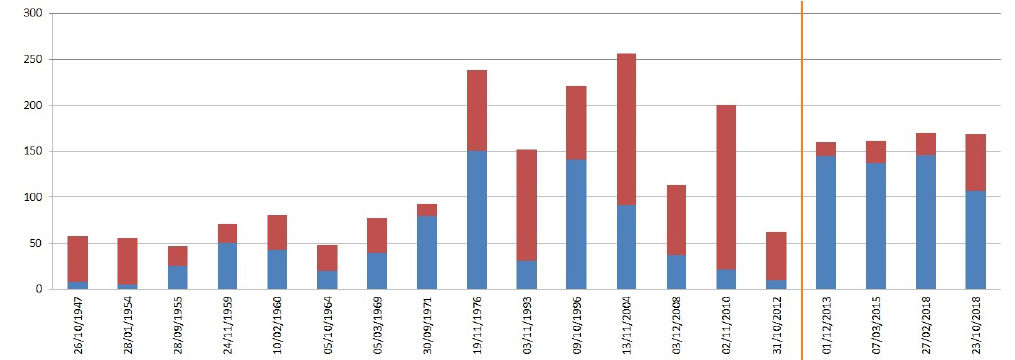
Figure 9. Two-weeks cumulative precipitation (mm) anticipating floods in the Asso Torrent basin (Nardò rain gauge); red segments refer to the rain the day before; data from Annali Idrologici of the Italian "Ufficio Idrografico e Mareografico" [35]. The orange line marks the end of the last extensive hydraulic